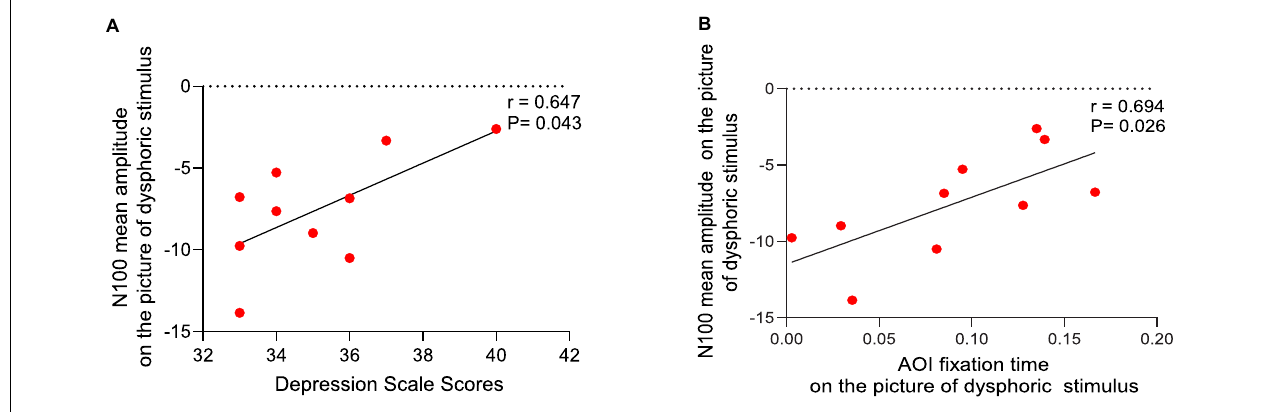
FIGURE 5 | Correlation analysis. (A) Relationship between depression scale scores and the mean N1 amplitude while looking at the dysphoric stimuli. (B) Relationship between the mean N1 amplitude and area of interest (AOI) fixation time while looking at the dysphoric stimuli.